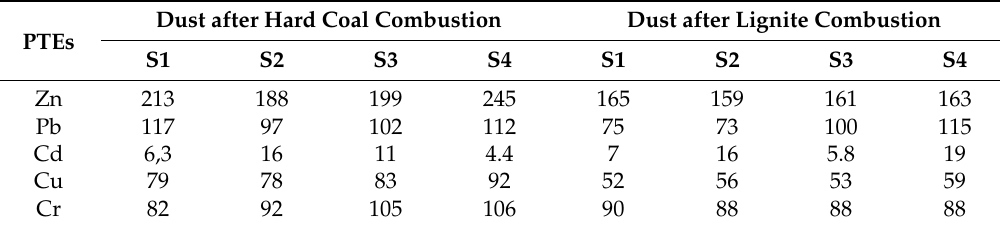
Table 2. Total content of analyzed potentially toxic elements (PTEs) (mg · kg − 1 ) in dusts. Dust after Hard Coal Combustion PTEs